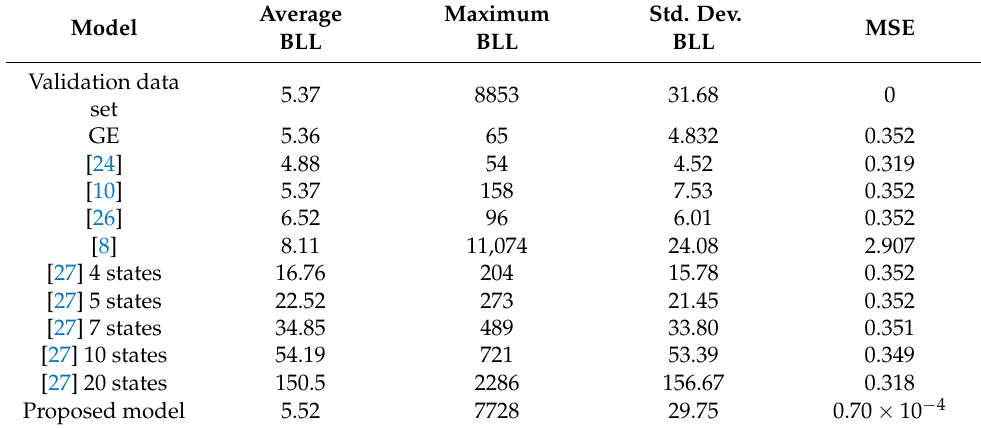
Table 6. Comparison of related works with the proposed